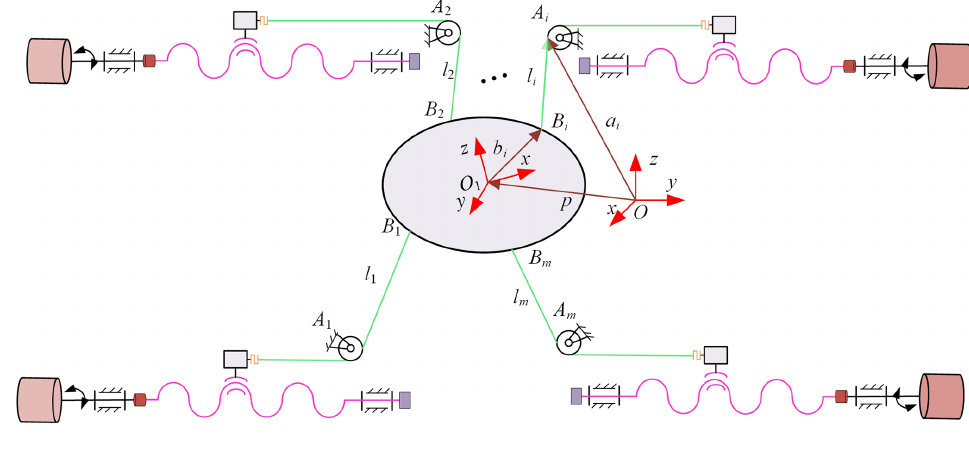
Figure 1. Schematic diagram of an n -DOF robot with m cables. Table 1. Local positions of eight anchor points (unit: millimeters).